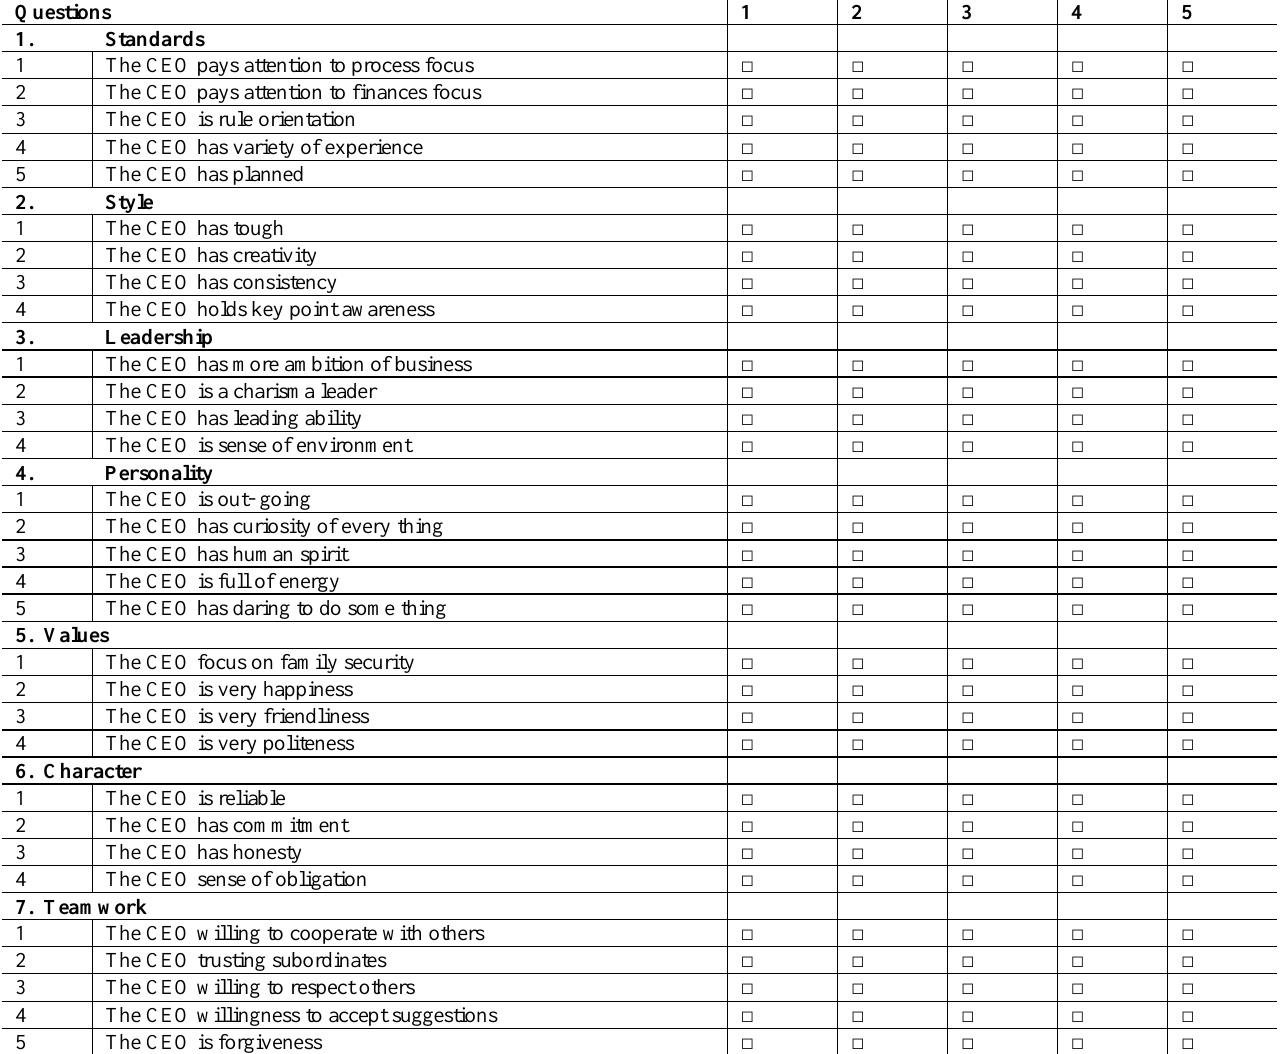
Table 8: Completed measure